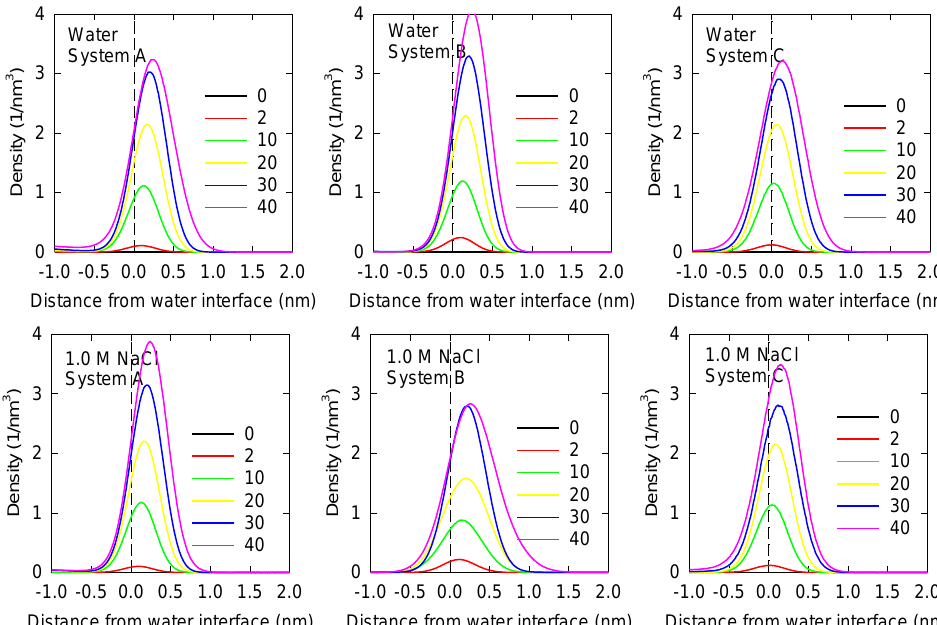
Figure 2. Axial density profiles of MIBC molecules in the vicinity of water liquid–vapor interfaces as a function of the concentration number of MIBC molecules (from 0 to 40) for water and 1.0 M NaCl solution for the three systems of interest (Table 2). Negative distances correspond to the liquid phase.